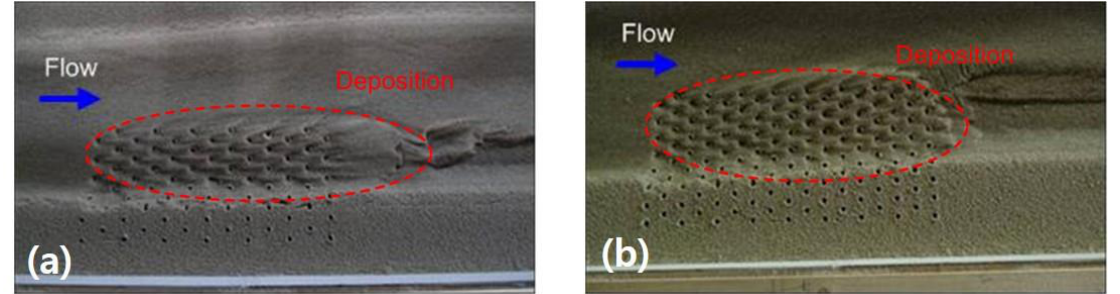
Figure 6. Spatial pattern of erosion and deposition within and around the patch for ( a ) low density and ( b ) high density.